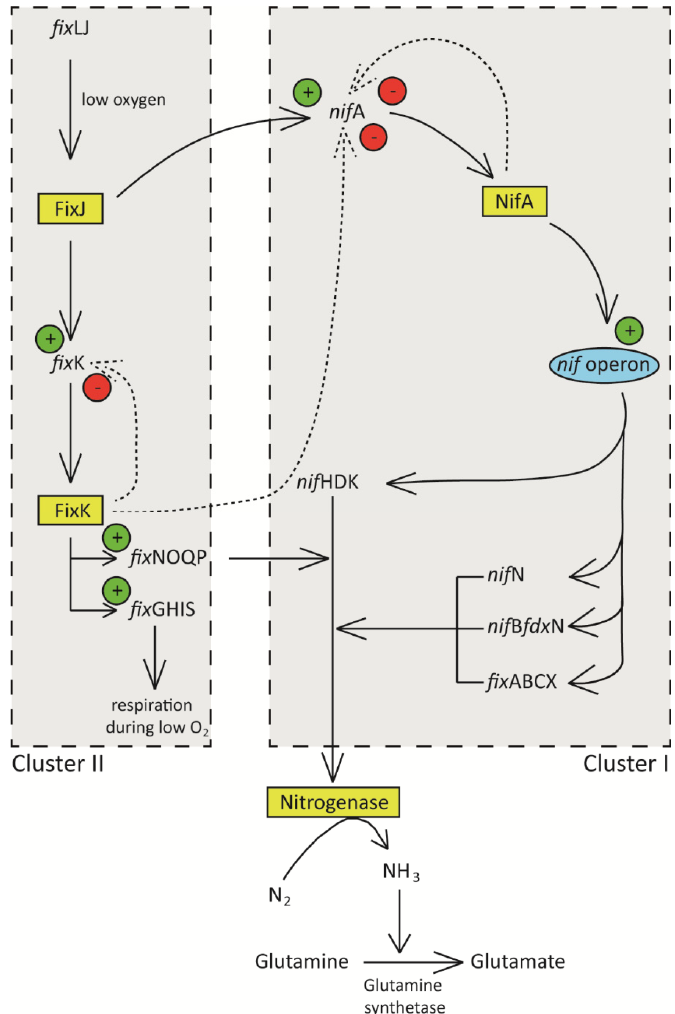
Figure 2. Schematic diagram showing regulation of nitrogen fixation in rhizobia. Low oxygen